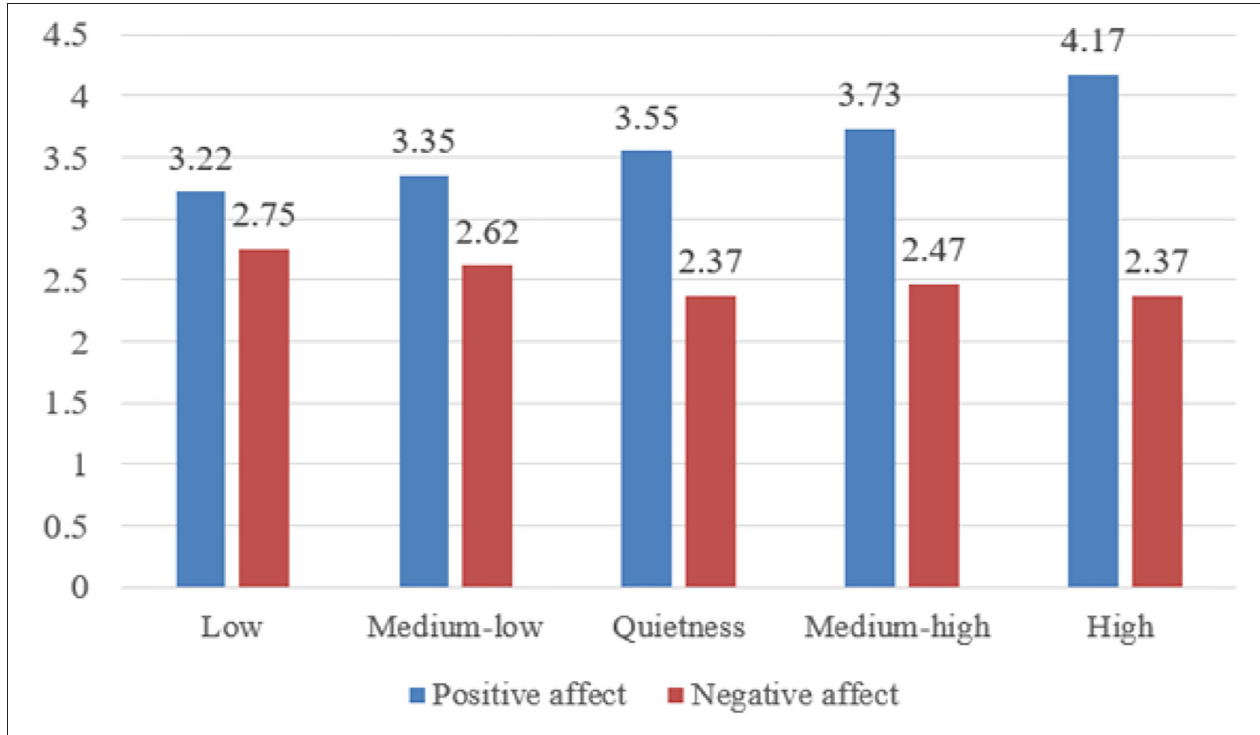
FIGURE 2 | Bar graph for